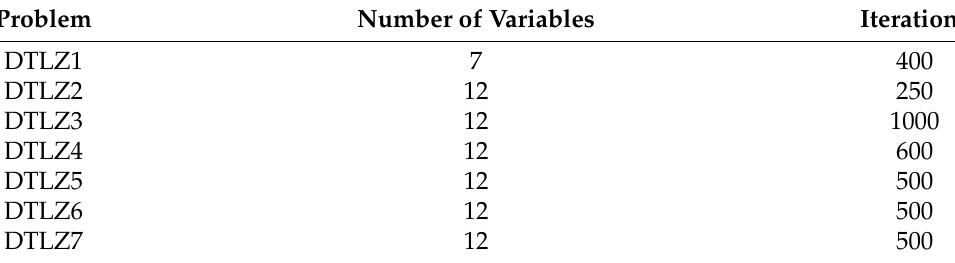
Table 1. Parameters Used for Three-Objective DTLZ Problem’s instances.